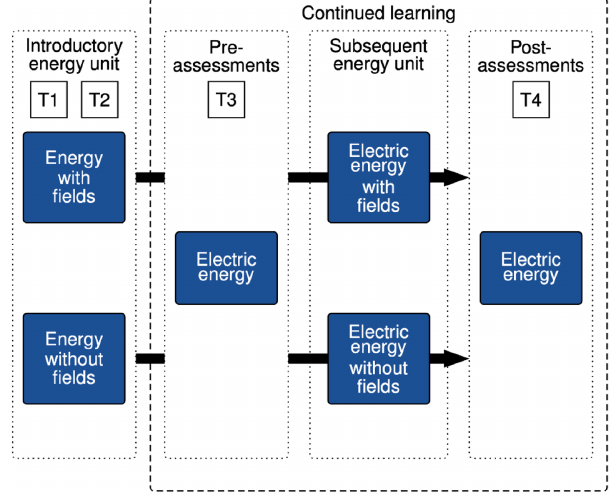
FIG. 1. Study design as a quasiexperimental pretest-post-test design with two intervention groups (fields and nonfields) and assessments before and after the